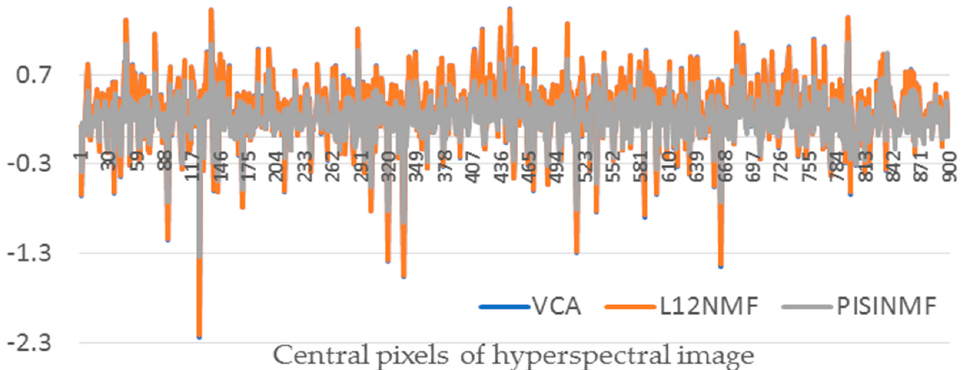
( b ) ( c ) Figure 8. The difference between the intrinsic structure of the true abundance and the intrinsic structure of the estimated abundance ( a ) The difference between the intrinsic structure of the true